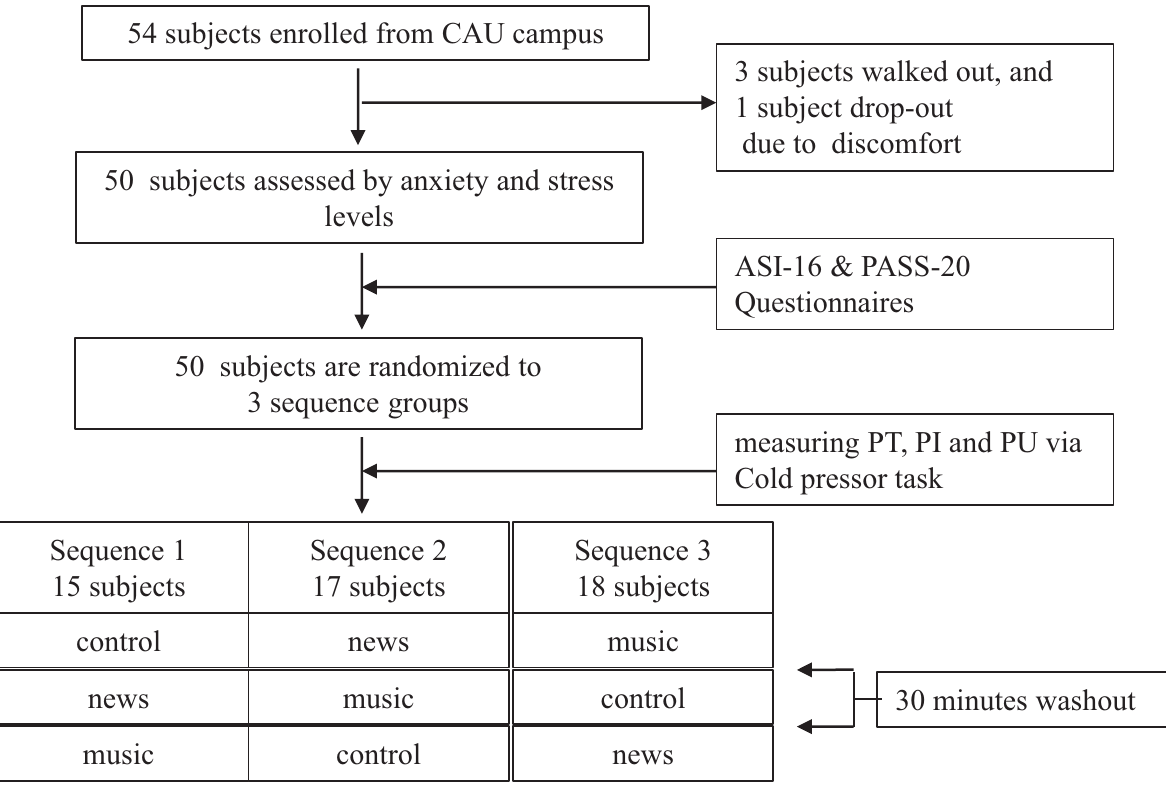
Fig 1. Flow chart depicting participant selection and protocol